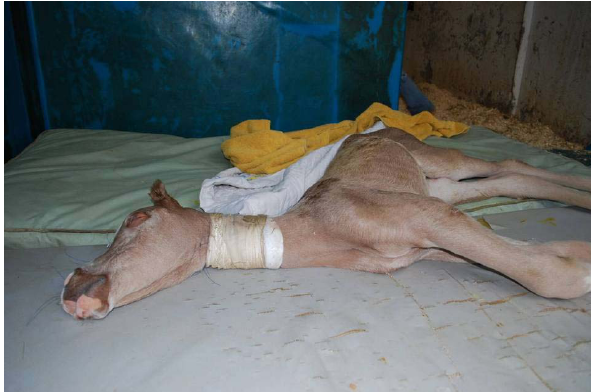
Figure 1. A foal with Lavender Foal Syndrome demonstrating opisthotonus, one cardinal neurological sign of the disorder. (Photo courtesy of Dr. Yael Giora).